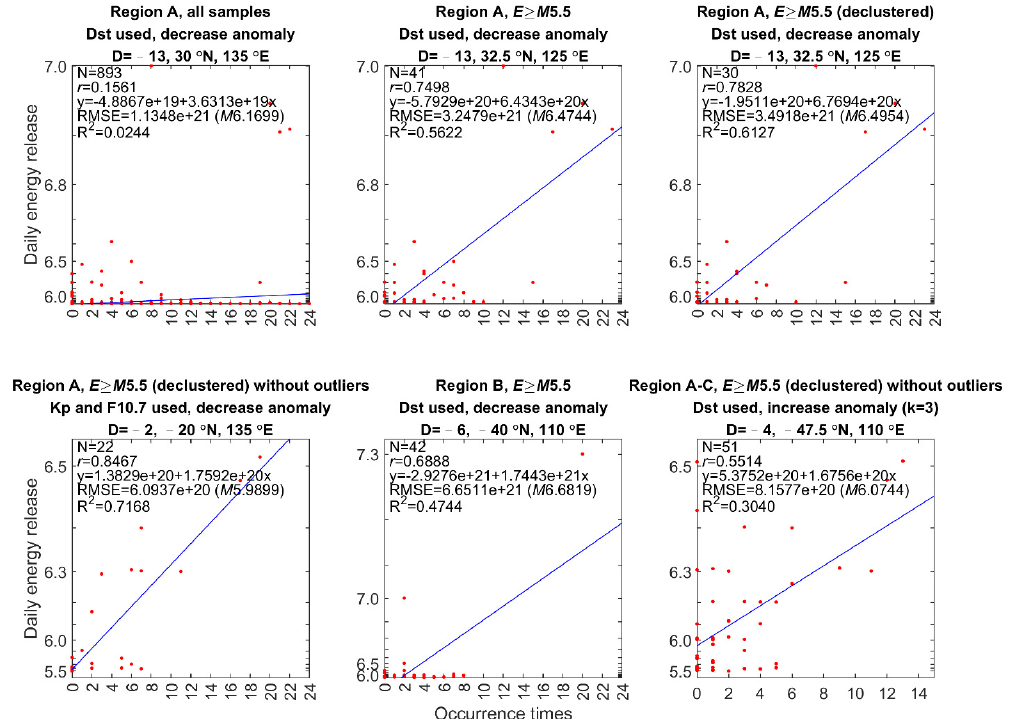
Figure 13. Linear regression models for samples with the minimum p values appearing in the 120°E sector and before the energy release. The time and locations of samples, anomaly types, and the methods used to eliminate the space weather effects are indicated in title. The sample size (N), r , equation of best fit line (x: occurrence times of TEC anomaly, y: daily seismic wave energy release in erg), RMSE (in erg and magnitude), and R 2 are shown in each panel. The unit of y-axis is erg, and the values and ticks are displayed with the corresponding magnitudes.